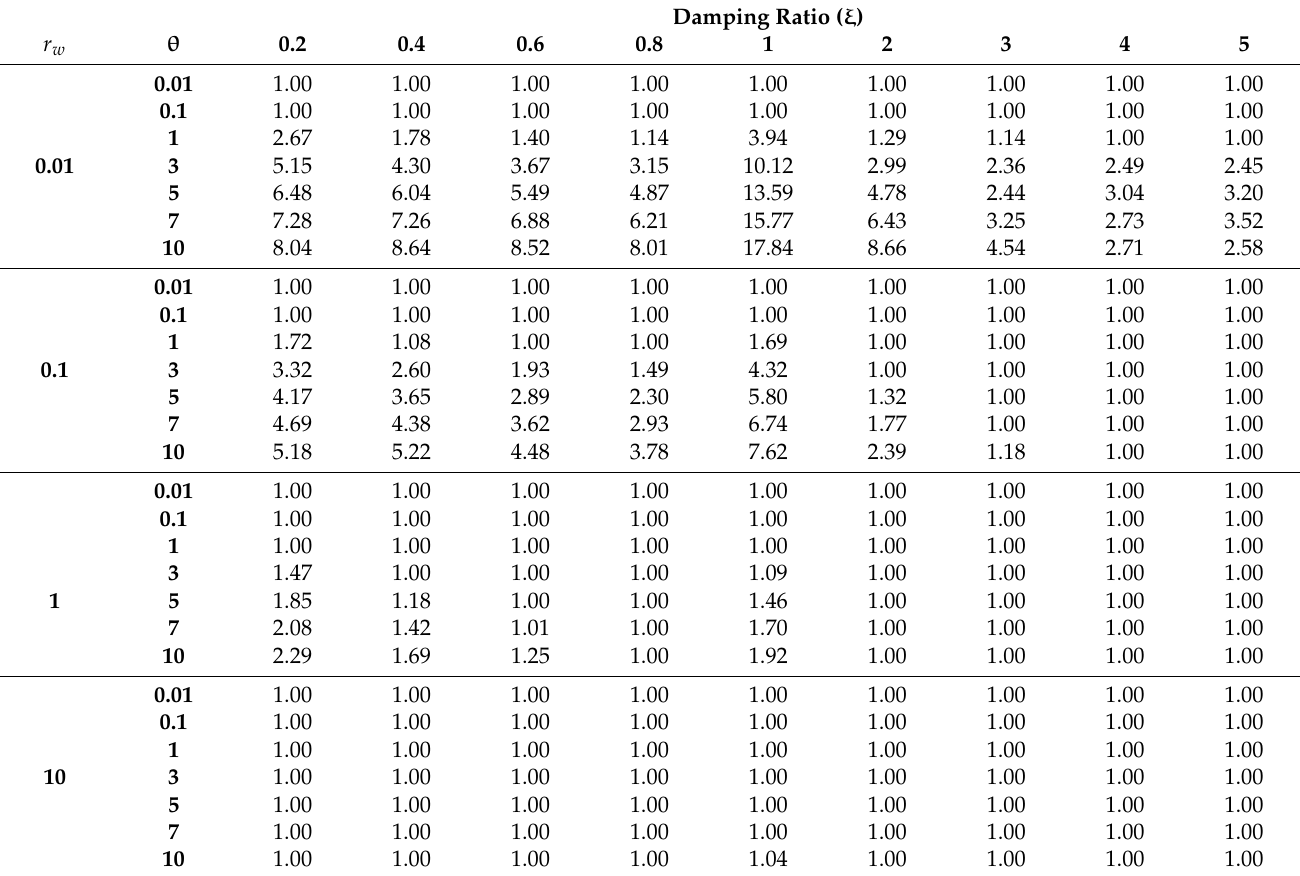
Table 9. Normalized TV for MPC (Process 3, setpoint response).